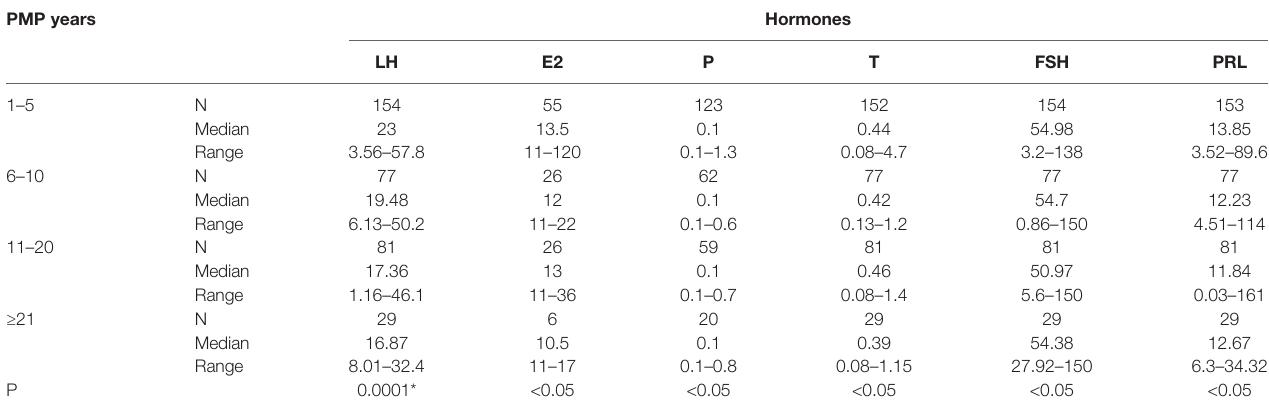
TABLE 2 | Association of PMP years with hormones in breast cancer